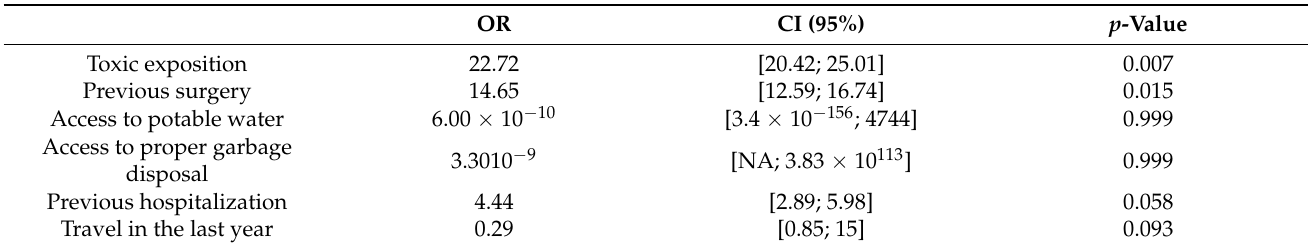
Table 3. Variables included in the binomial logistic regression